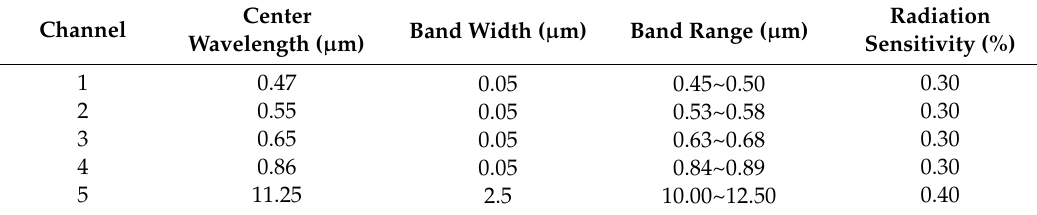
Table 1. The 250 m resolution channel specification of MERIS.